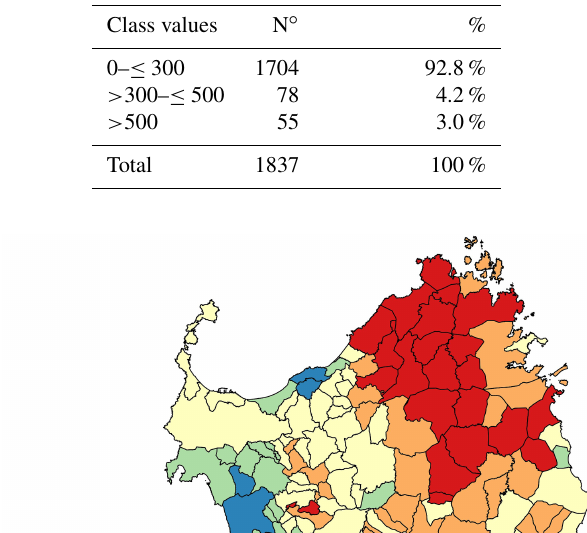
Table 5. Buildings and radon concentration detected during the Sardinia Regional Agency for Environmental Protection Radon Project.